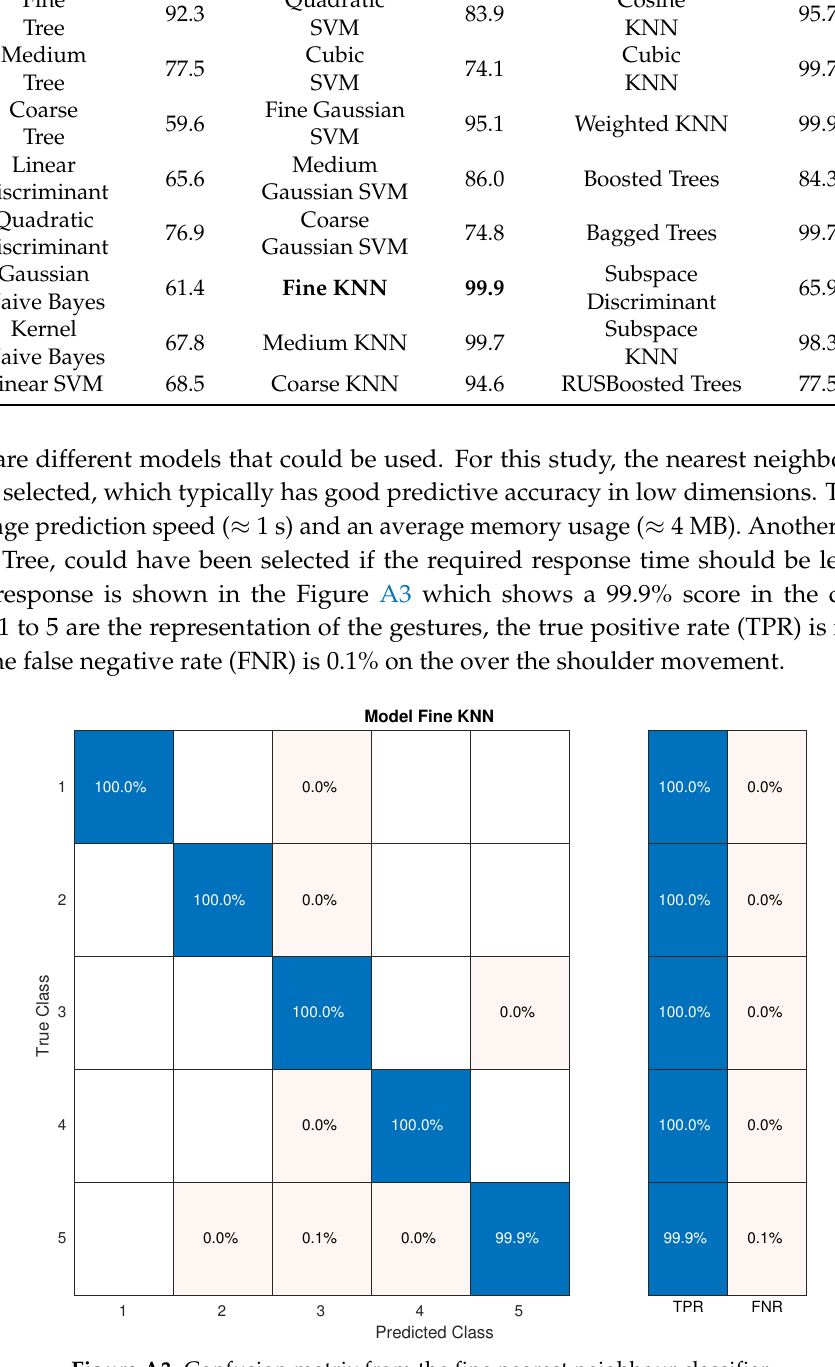
Figure A3. Confusion matrix from the fine nearest neighbour